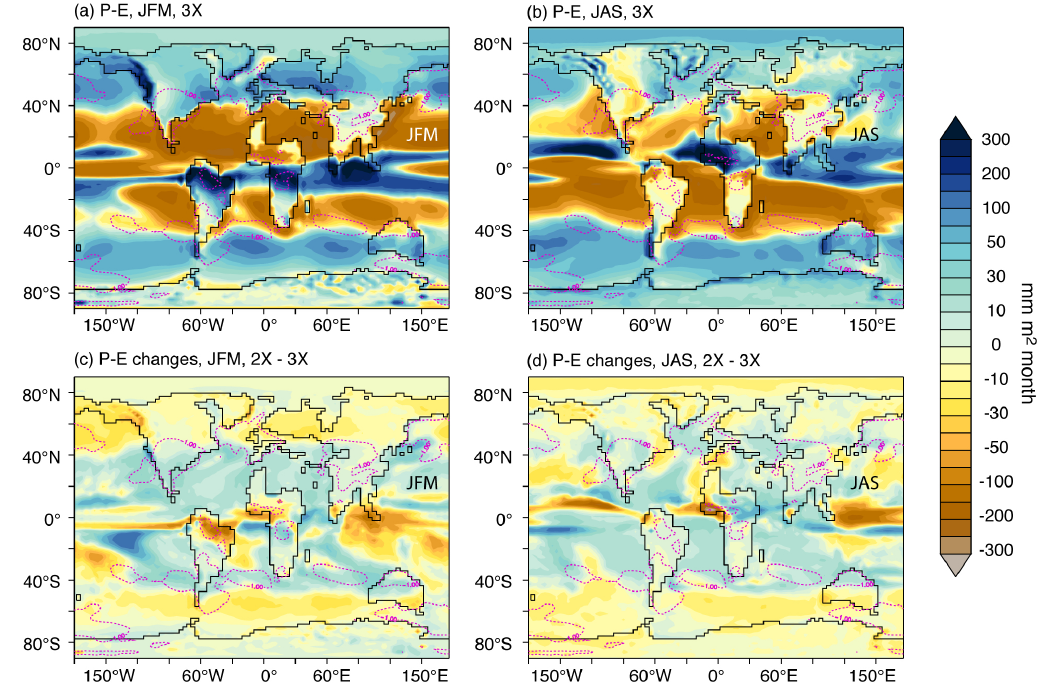
Figure 5. Net precipitation (precipitation − evaporation) in JAS and JFM for the late Eocene simulation 3 X (a, b) . Changes associated with p CO 2 drop from 3 X to 2 X (differences shown are 2 X − 3 X ) for net precipitation (c, d) . Magenta dashed lines contour areas with decreased seasonality ( (cid:49) MATR ≤ − 1 ◦ C) in 2 X − 3 X simulations (blue zones in Fig.